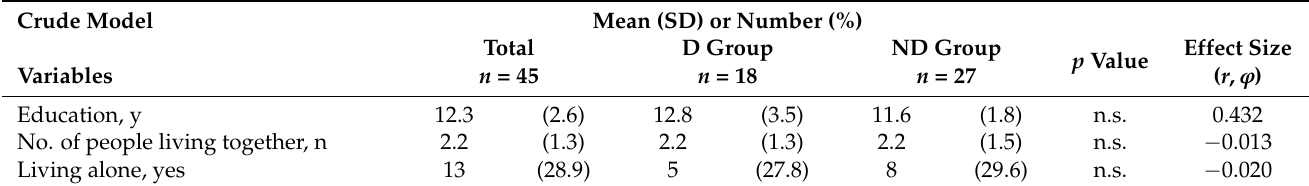
Table 2. Comparison between the two groups: D group and ND